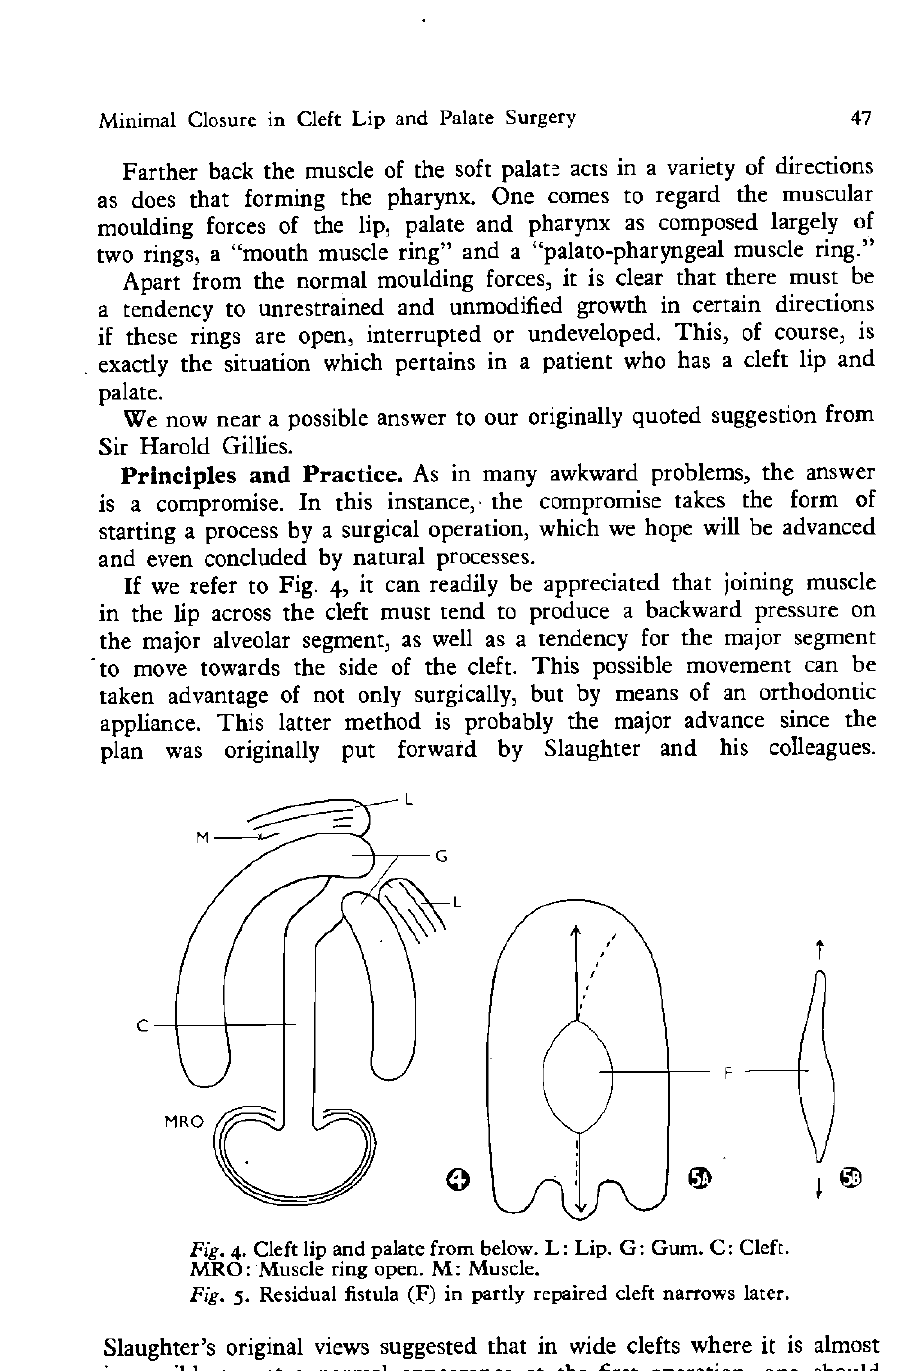
Fig. 4. Cleft lip and palate from below. L: Lip. G: Gum. C: Cleft. MRO: Muscle ring open. M: Muscle. Fig. 5. Residual fistula (F) in partly repaired cleft narrows